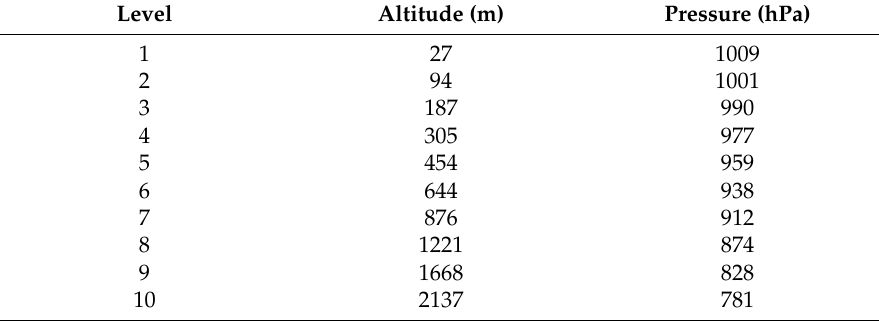
Table A1. List of approximate altitude (m) and pressure (hPa) for each eta